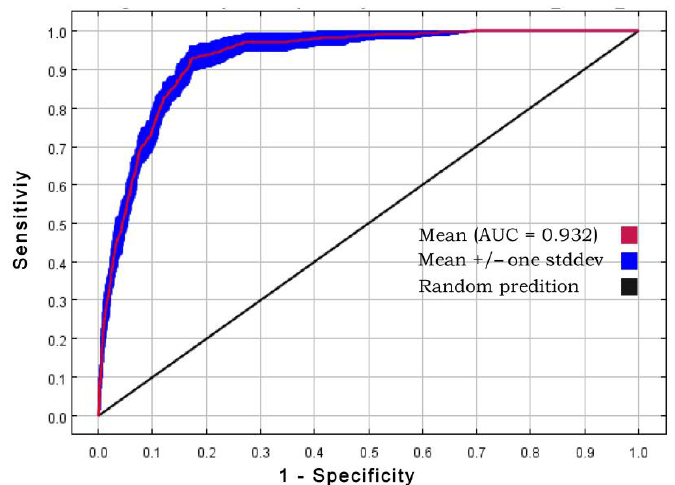
Figure 2. Receiver operating characteristic (ROC) curve of results obtained from the simulation performed ten times.